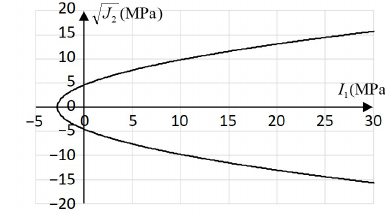
Figure 4. Nonlinear Drucker-Prager yield